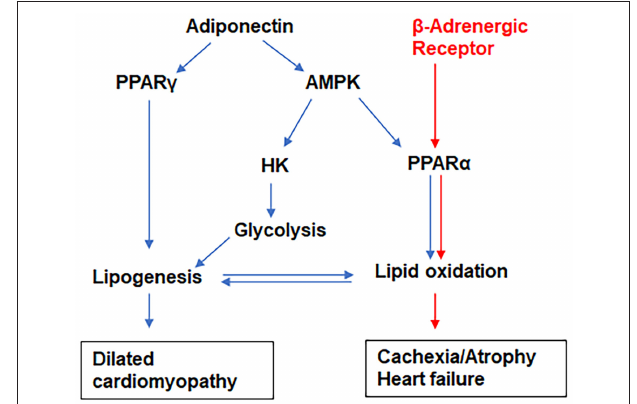
FIGURE 9 | The proposed models of signaling pathways that differentiate the pathogenesis of dilated cardiomyopathy (indicated by blue arrows) and cachexia (indicated by red arrows) in male and female coinfected mice, respectively. The adiponectin/AMPK/glycolysis pathway dominates in the hearts of male coinfected mice, whereas β -adrenergic receptor signaling activates lipid metabolic pathways in female coinfected